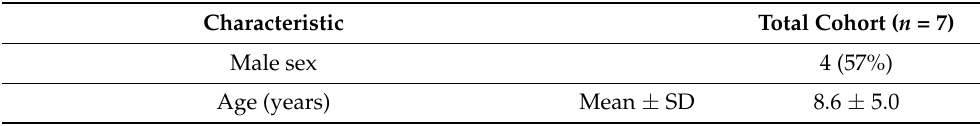
Table A1. Characteristics of patients with pre-transplant